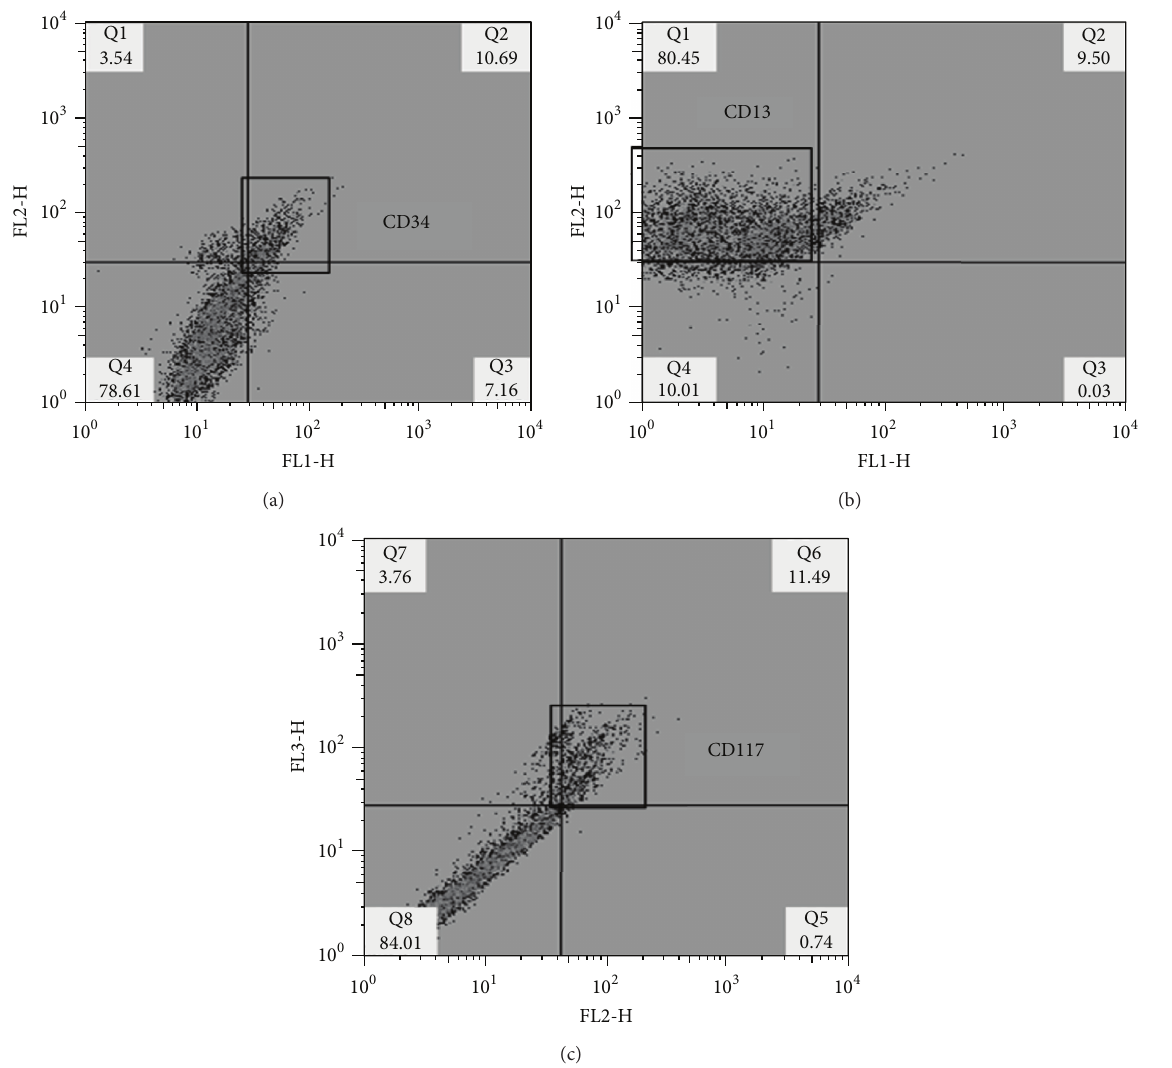
Figure 1: Bone marrow stromal cells (BMSCs) flow cytometry with Cd13 and Cd117. (a) Population of Cd34-positive cells (10.69%). (b) Population of Cd13-positive BMSCs (80.45%). (c) Population of Cd117-positive BMSCs (11.49%).